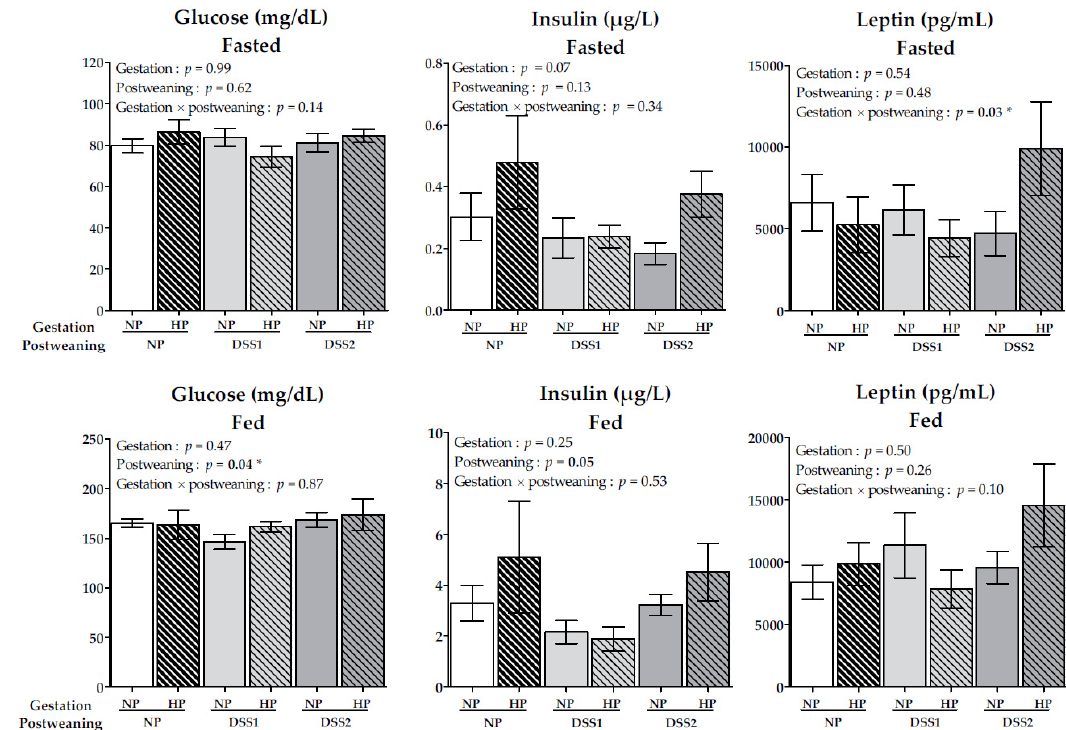
Figure 4. Fasted and fed ( 90 minutes after calibrated meal) blood and plasma glucose (mg/dL), insulin (µg/L) and leptin (pg/mL) levels. Data are means ± SEMs. Effects of diets were tested within model W (*, P < 0.05). NP, Normal-Protein (control); HP, High-Protein; DSS1, Dietary Self-Selection 1 (P and G/L in 2 different cups); DSS2, Dietary Self-Selection 2 (P, G and L in 3 different cups).